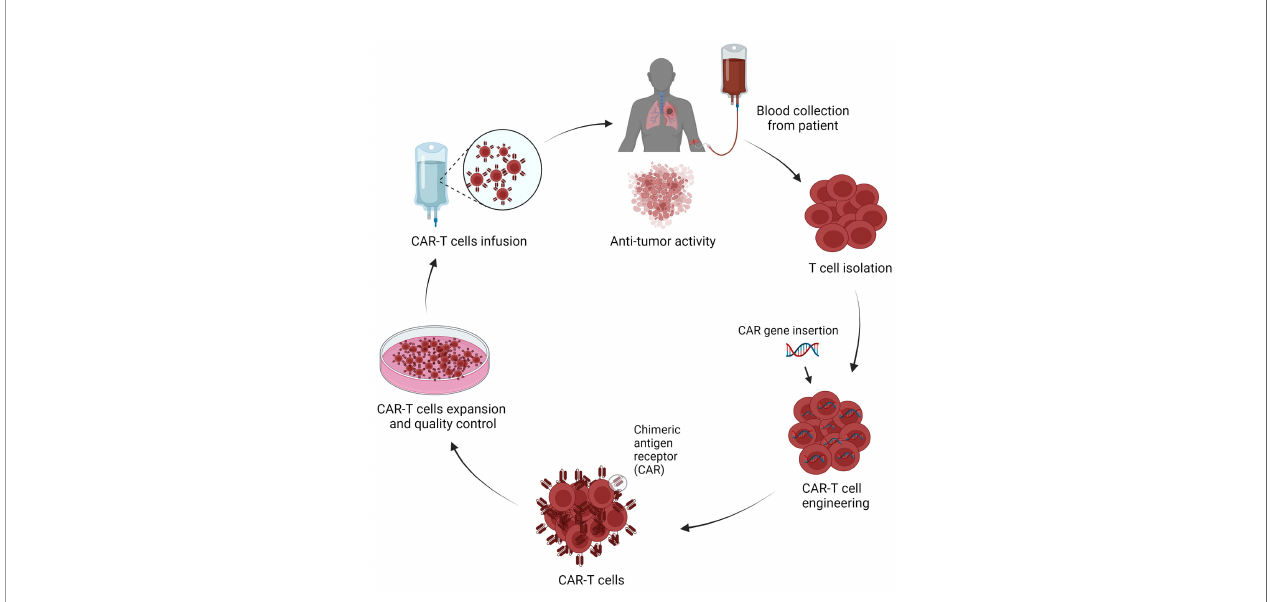
FIGURE 2 | Schematic representation of CAR-T cells production and application in lung cancer treatment (Figure generated using Bio